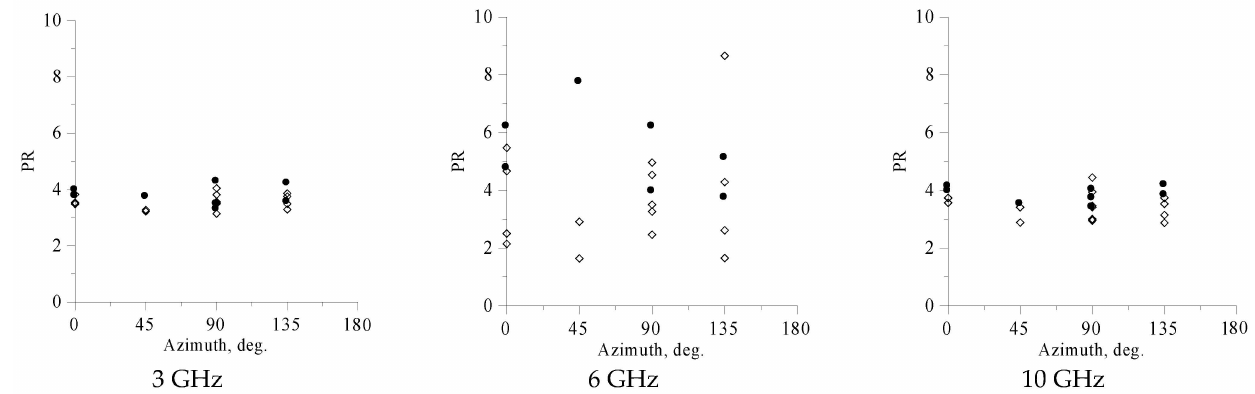
Figure 3. PR for nonslicks and for slicks at an incidence angle of 60°. Open symbols — nonslicks, solid symbols — slicks. GWR, 2021, wind velocity of 5 – 6 m/s.